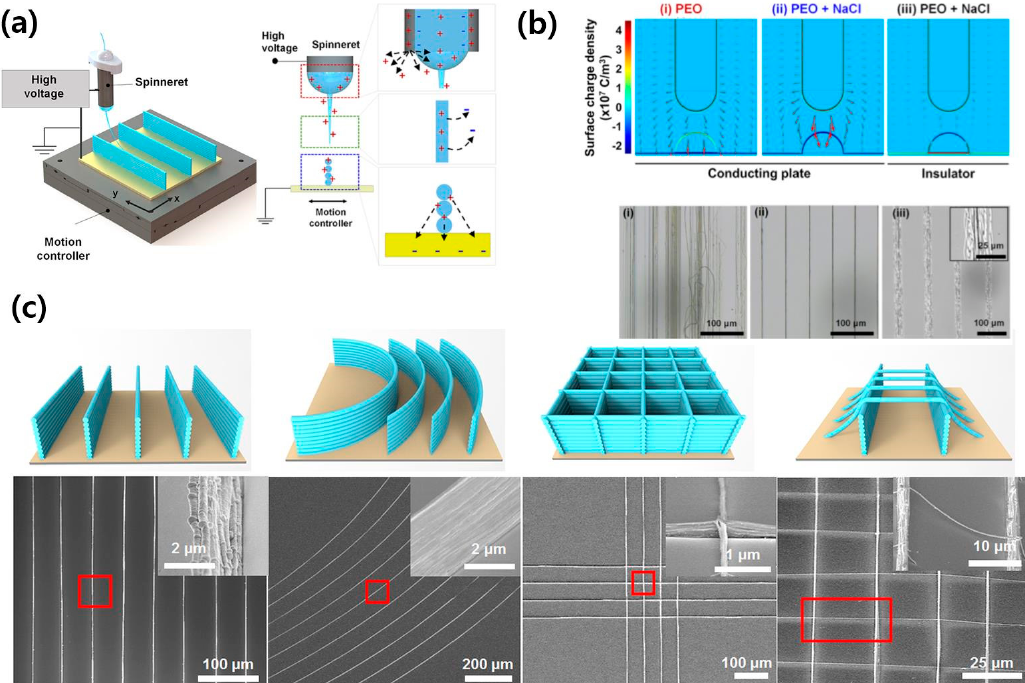
Figure 9. ( a ) Schematic illustration of experimental setup of NFSE, ( b ) diagram showing surface charge density for pure poly(ethylene oxide) (PEO) and PEO / NaCl on conducting plate, and PEO / NaCl on insulating plate, and ( c ) fabricated various 3D nanoarchitecutres, i.e., nanowalls, curved nanowalls, grid pattern, and nanobridges. [Adapted with permission from 87. Copyright (2019) American Chemical Society].